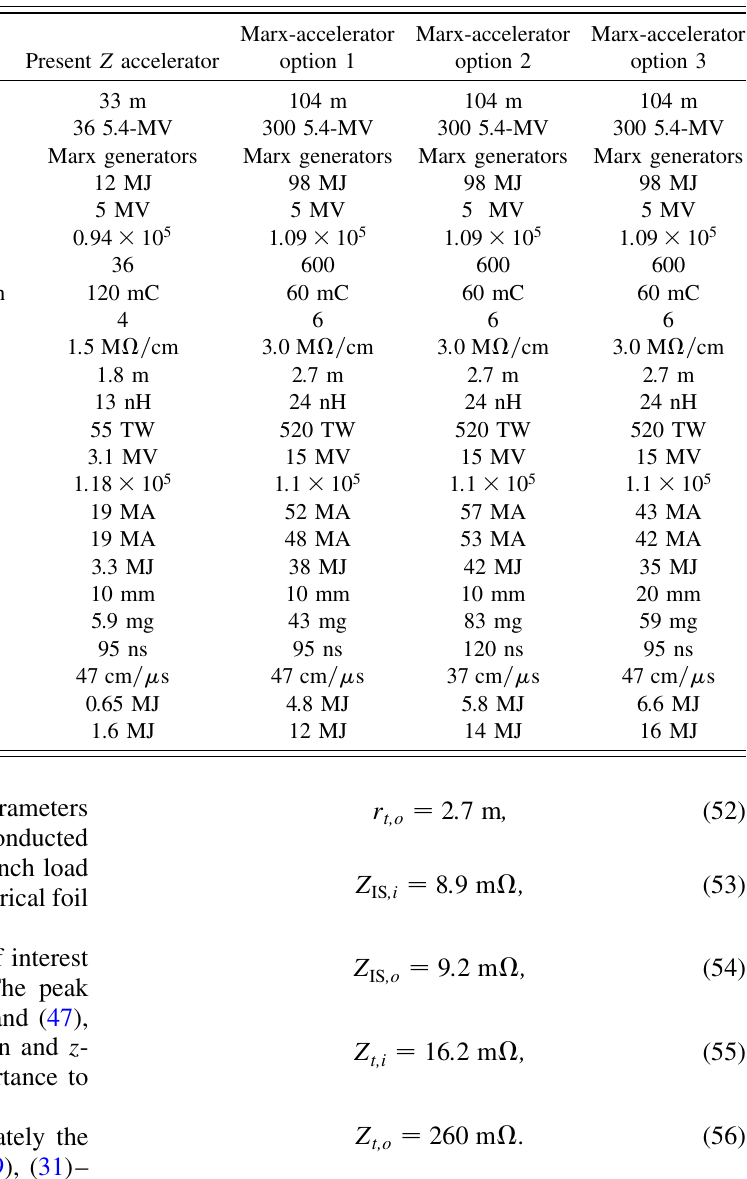
ARCHITECTURE OF PETAWATT-CLASS z -PINCH . . TABLE I. Accelerator and z -pinch parameters for three Marx-based-accelerator options. The parameters are compared to those of the existing Z accelerator [22–31,40,42]. For these options the design of the accelerator itself is identical; the options differ only due to differences in the z -pinch loads. For the Z accelerator and all three higher-current options, the initial pinch radius is assumed to be 10 mm. The nominal values of the peak pinch implosion velocity and kinetic energy assume a 10:1 pinch-radius convergence ratio. The effective peak pinch current and effective implosion time are defined in Appendix C.